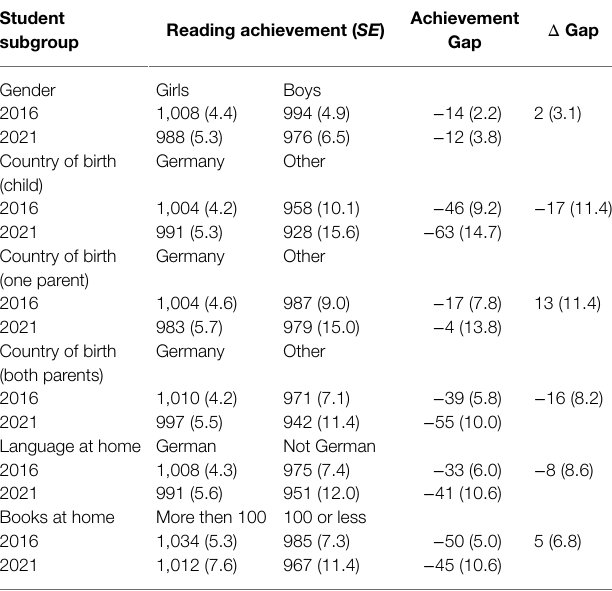
TABLE 2 | Reading achievement gaps in different student subgroups. Student